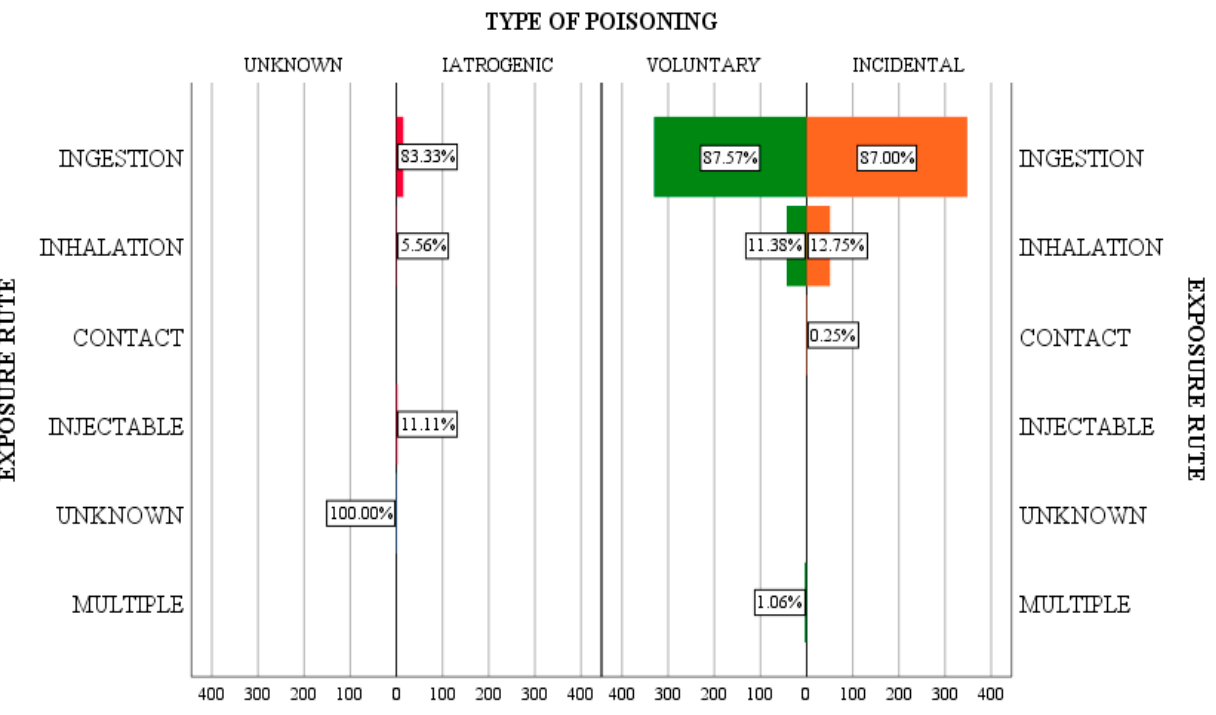
Figure 3. The incidence of poisoning in correlation to the exposure route.